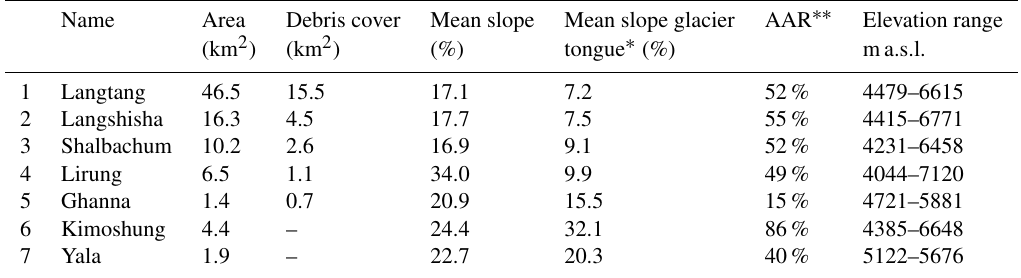
Table 1. Characteristics of the studied glaciers in the upper Langtang catchment. The measures are based on the SRTM 1arcsec Global DEM and glacier outlines of 2006.